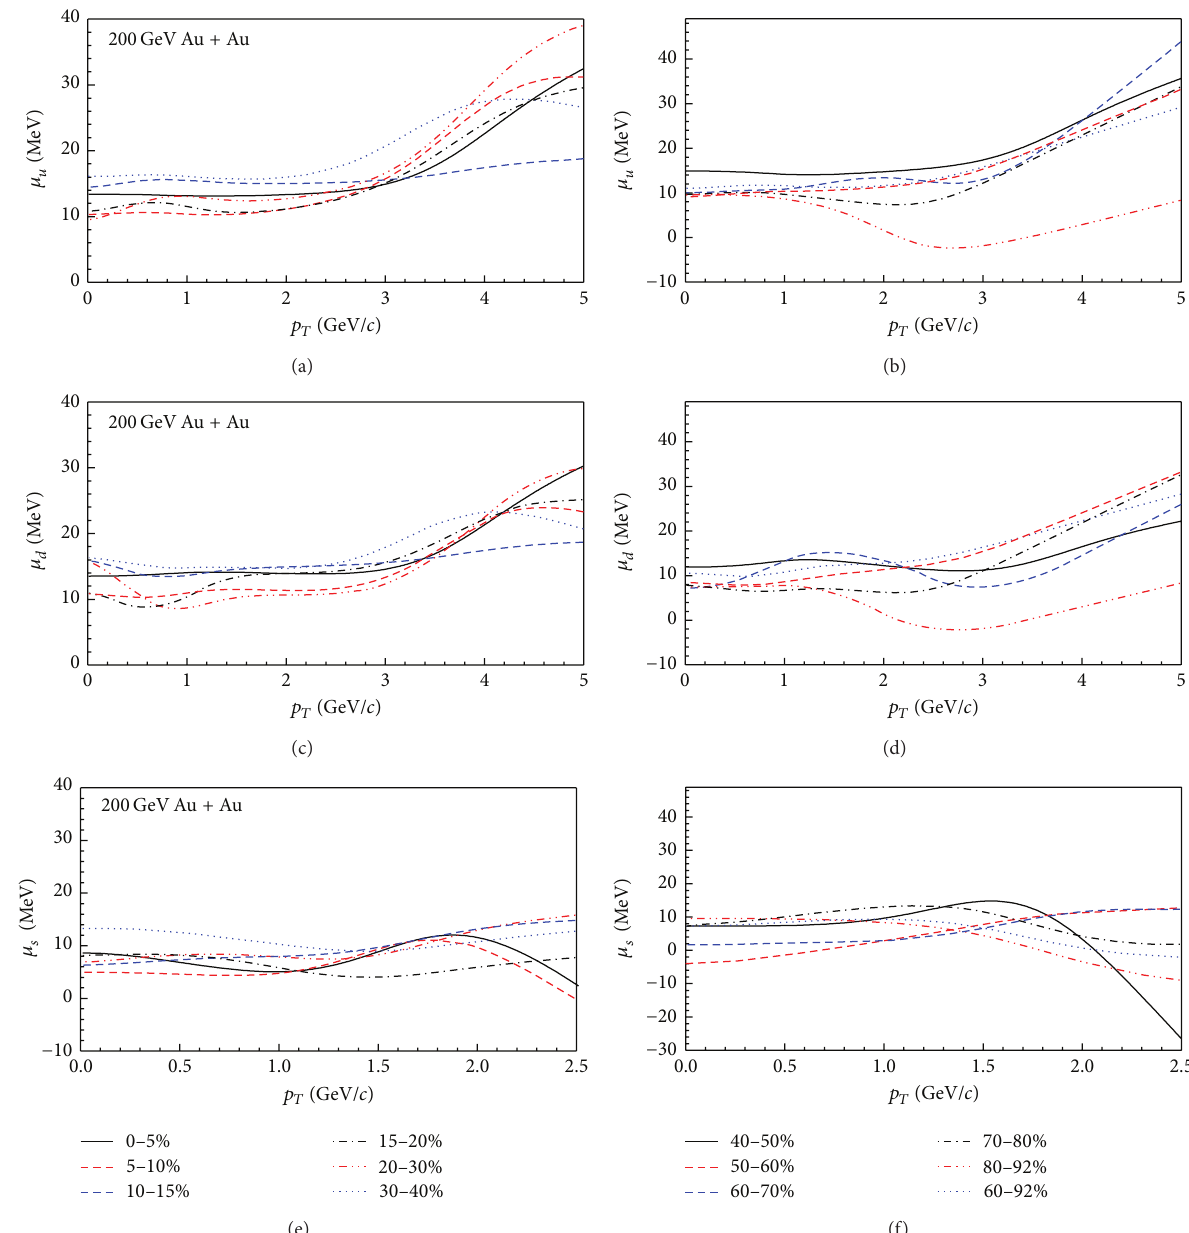
Figure 8: The same as Figure 7, but showing only the results in Au-Au collisions at √𝑠 𝑁𝑁 = 200 GeV for more centrality classes.